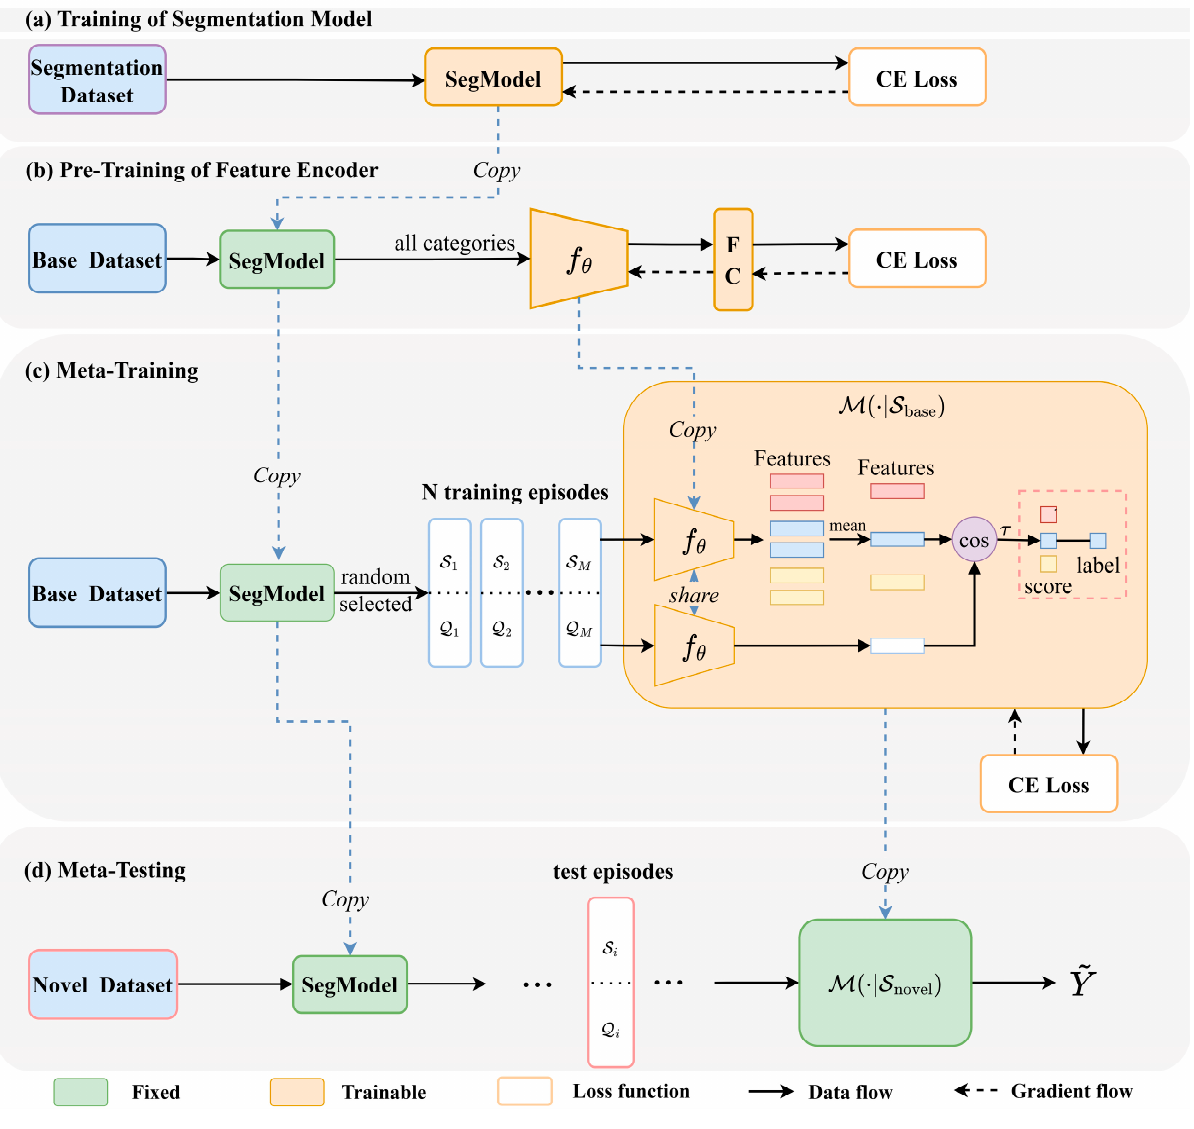
Figure 5. The framework of the proposed method. ( a ) Training the pre-segmentation model using the segmentation label of the TCS environment pattern dataset; ( b ) training a CNN with all of the categories; by removing the FC layer, the network generates a feature encoder, f θ ; ( c ) training the meta-classification model by optimizing the parameter θ from multiple episodes; ( d ) evaluating the performance of the meta-classification model by sampling new episodes from the test set.